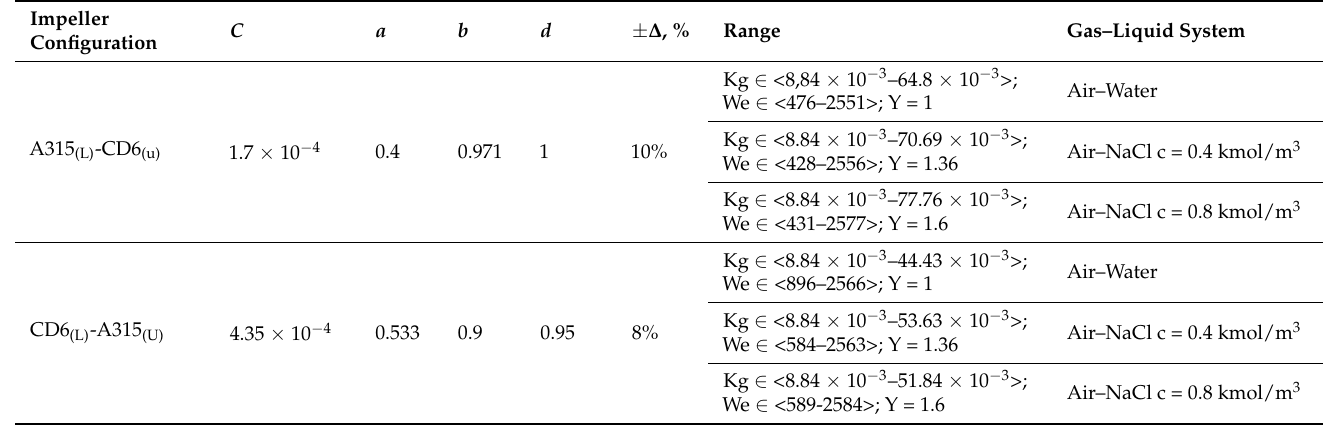
Table 3. Values of coefficient C and exponents a , b and d in Equation (6), the average relative error and ranges of the number of gas flow Kg, number of Weber We and parameter